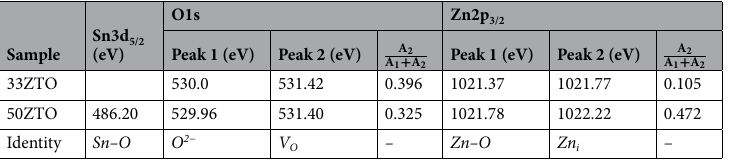
Table 2. Details of the fitting parameters for Sn3d, O1s and Zn2p core level XPS spectra of zinc tin oxide thinfilms. A 1 and A 2 represent integrated peak areas of the peak 1 and peak 2,